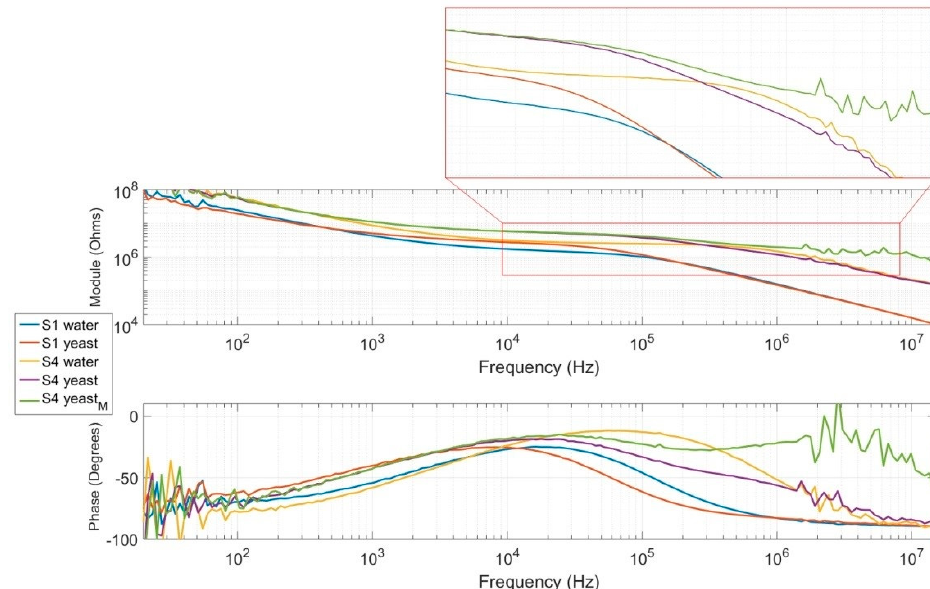
Figure 7. Measured impedance module and phase of new (S4) and previous-generation (S1) sensors with a yeast cell cap on the measurement area.